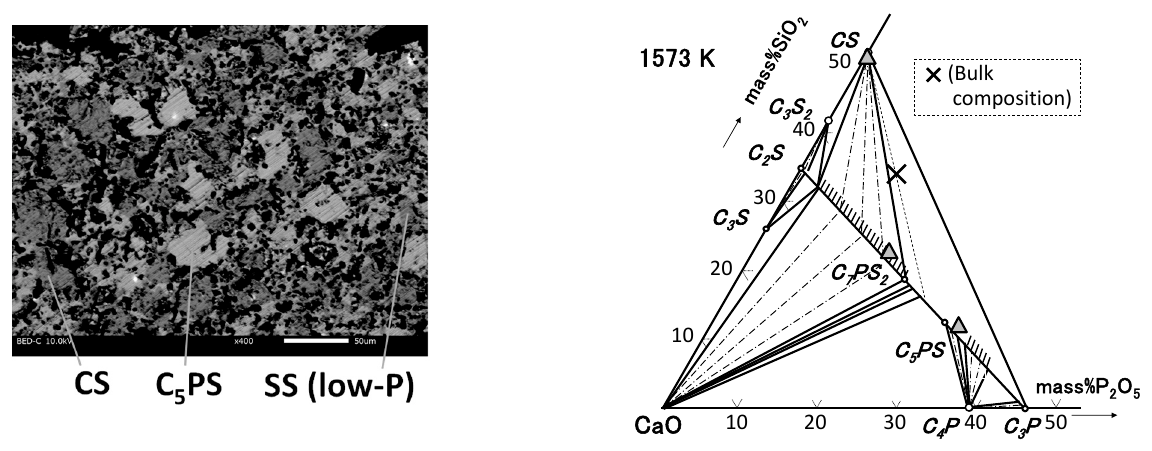
Figure 3. SEM image of M1-0 ( left ) and phase composition projected on isothermal section of CaO- SiO 2 -P 2 O 5 ternary phase diagram at 1573 K ( right ).